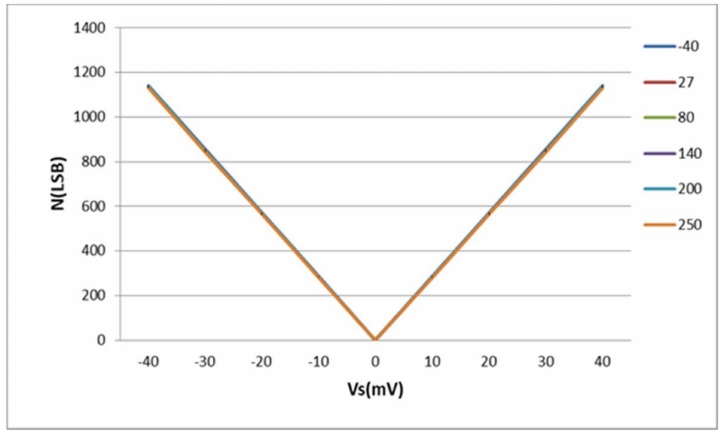
Figure 12. Simulated characteristic function of the sensor interface [ − 40 ◦ C, 250 ◦